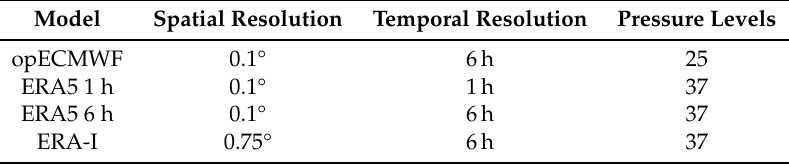
Table 2. Parameters of the applied numerical weather-model-based atmosphere